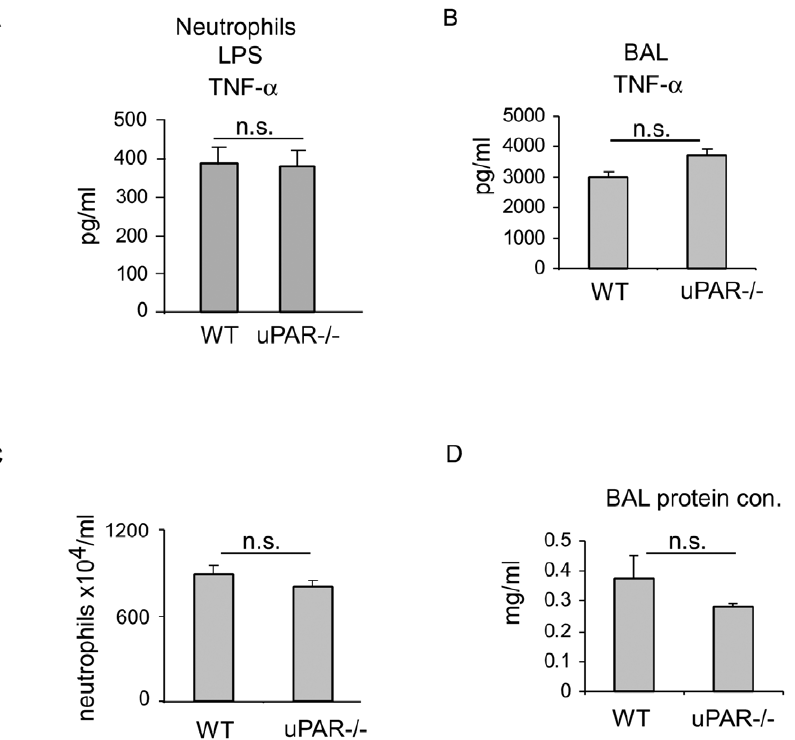
Figure 6. uPAR is not required for neutrophil activation upon TLR4 stimulation. (A) 1 6 10 6 WT and uPAR-/- neutrophils were treated with 10 ng/ml LPS for 4 hours and the levels of TNF- a in the supernatants determined. Mean + SD. (B–D) WT and uPAR-/- mice were given LPS intratracheally (50 m g/mouse in 50 m l PBS). 24 hours after LPS instillation, the mice were sacrificed and BAL fluids collected. BAL levels of TNF- a were determined by ELISA (B), neutrophils in BAL counted (C), and BAL protein concentrations determined (D). 4–5 mice in each group, mean 6 SEM. All p values were greater than 0.05. n.s. indicates non-significant between groups.